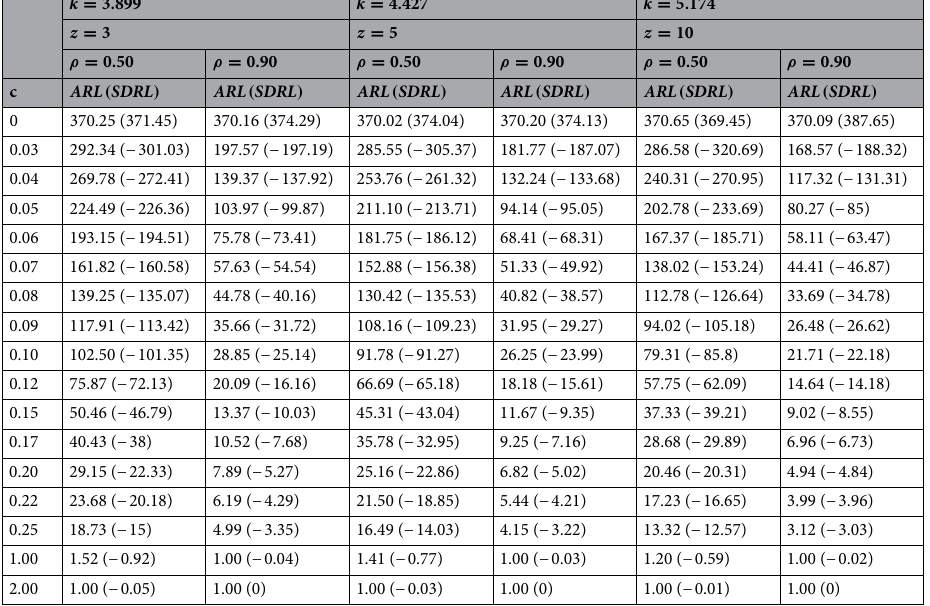
Table 8. ARLs of EEWMA-REMA control chart when ARL 0 = 370, n = 5, (cid:31) 1 = 0.3, (cid:31) 2 = 0.15 .